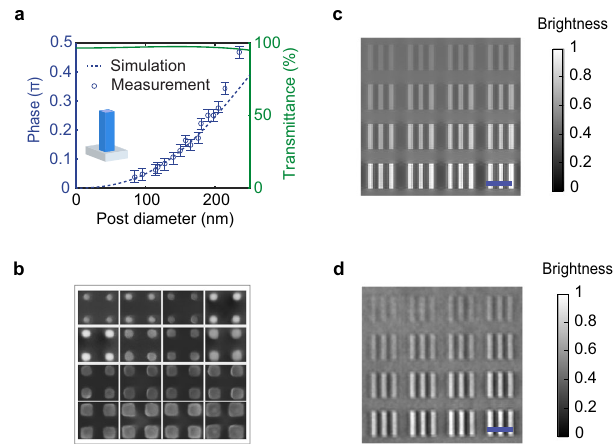
Fig. 5 | Quantitative phase retrieval using an NLM. a Transmission and phase delay from 2D periodic arrays of Si 3 N 4 nanorods with heights of h =230nm and latticeconstant a =360nm.Theinsetshowsthestructureofasinglecell.Theerror bars show a reference of ±0 : 02 π phase difference with respect to the measured phase. b SEM image of different area of the fabricated metasurface. c Simulated NLM phase contrast image. d Measured NLM phase contrast image. Scale bar corresponds to 20 µ